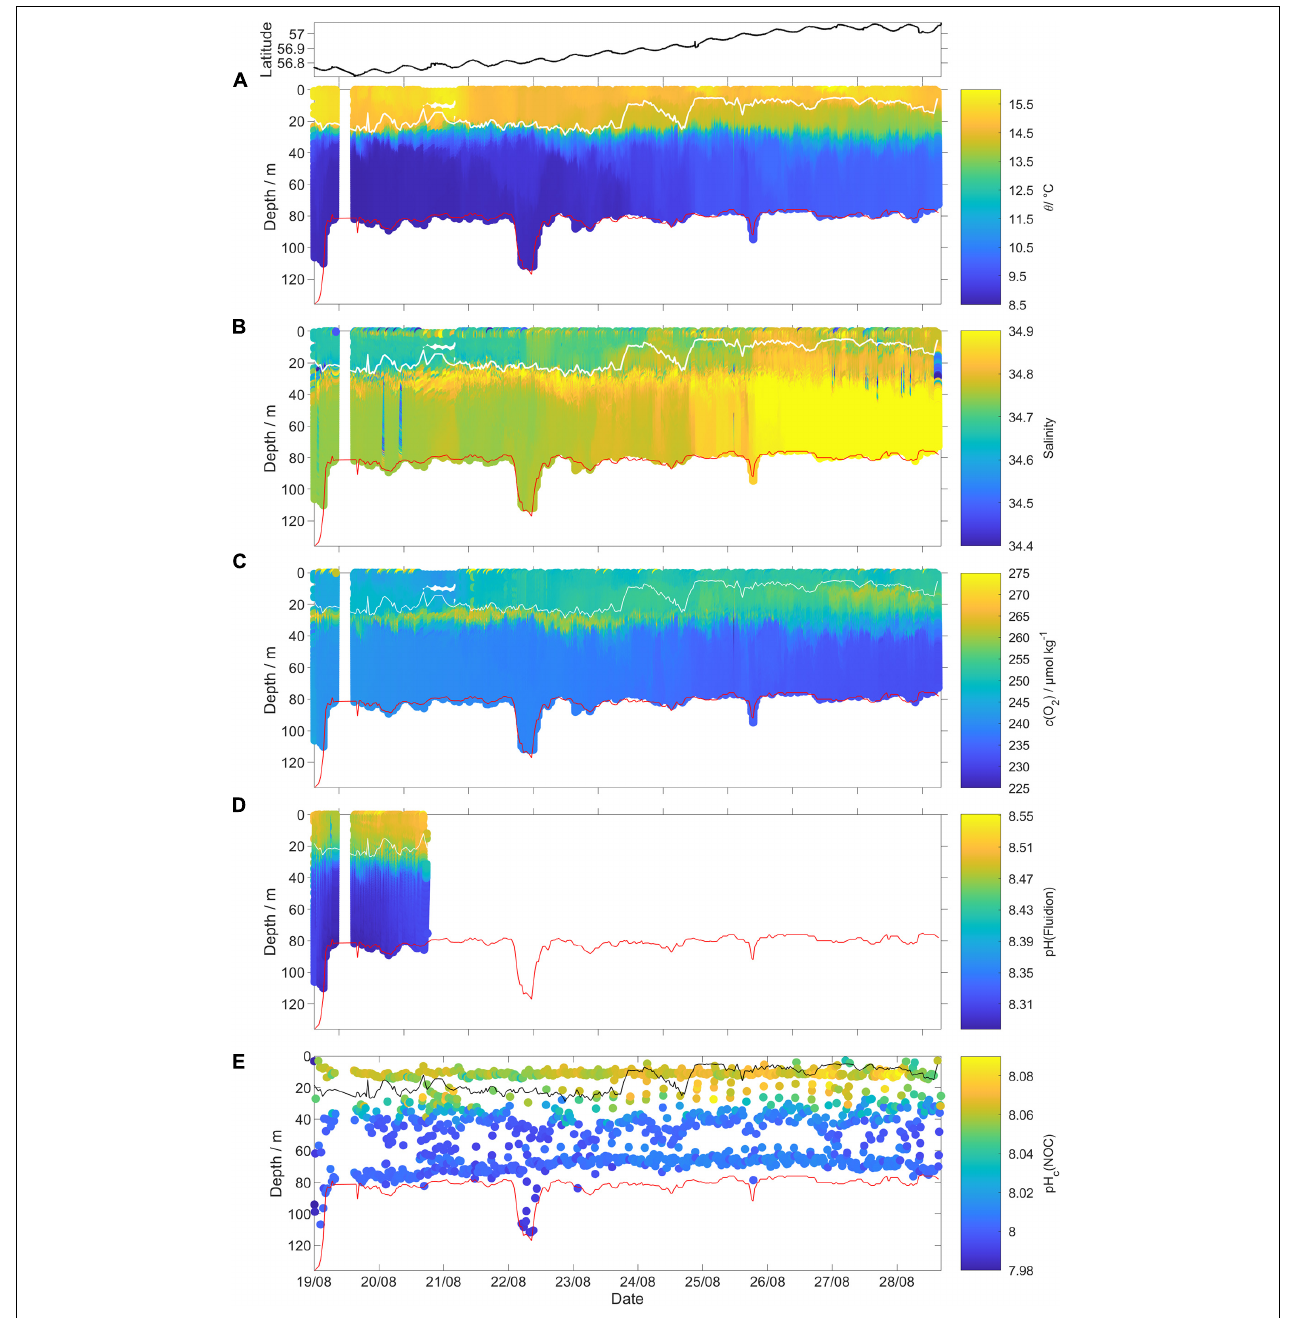
FIGURE 3 | Uncalibrated glider data for all 341 dives (top panel: latitude of the glider location). (A) Potential temperature θ , (B) practical salinity S , (C) dissolved oxygen content c (O 2 ), (D) pH(Fluidion), and (E) temperature corrected pH c (NOC). The measurements taken during the glider ascent were removed for θ , S , and c (O 2 ). The white lines in (A–D) and the black line in (E) show the surface mixed layer depth ( z mix ) and the red lines show the GEBCO 2019 bathymetry